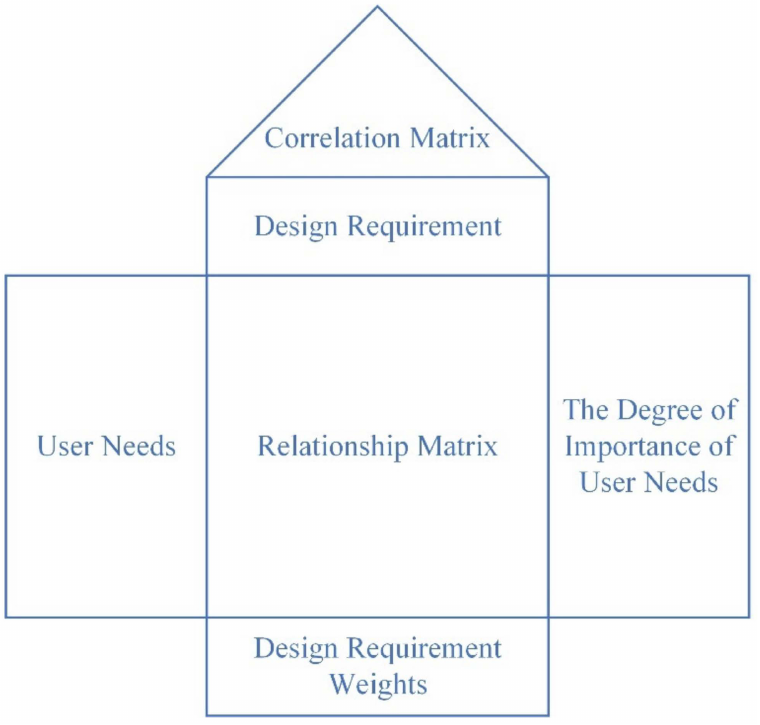
Figure 1. QFD house of